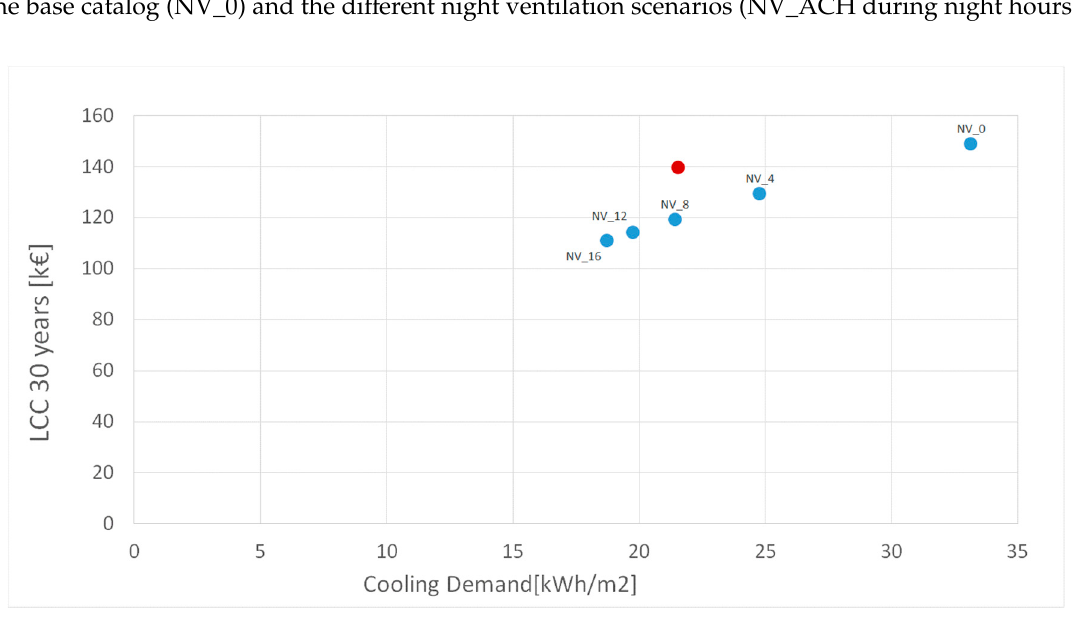
Figure 13. Life cycle analysis using the advanced catalog.